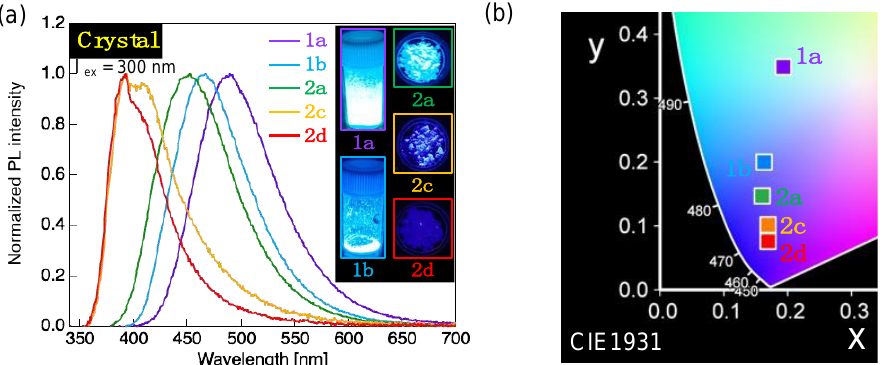
Figure 4. ( a ) PL spectra of semifluoroalkoxy-containing D- π -A-type fluorinated tolanes 1 and 2 in the crystalline phase ( λ ex = 300 nm). Inset: Photographs of PL by the tolanes under UV irradiation ( λ ex = 365 nm). ( b ) CIE plot of the tolanes calculated from their PL spectra. Thus, 1a had a single PL band with a λ PL around 490 nm and a light-blue PL at ( x , y ) = (0.193, 0.349) CIE coordinates with a high PL efficiency ( Φ PL = 0.61).